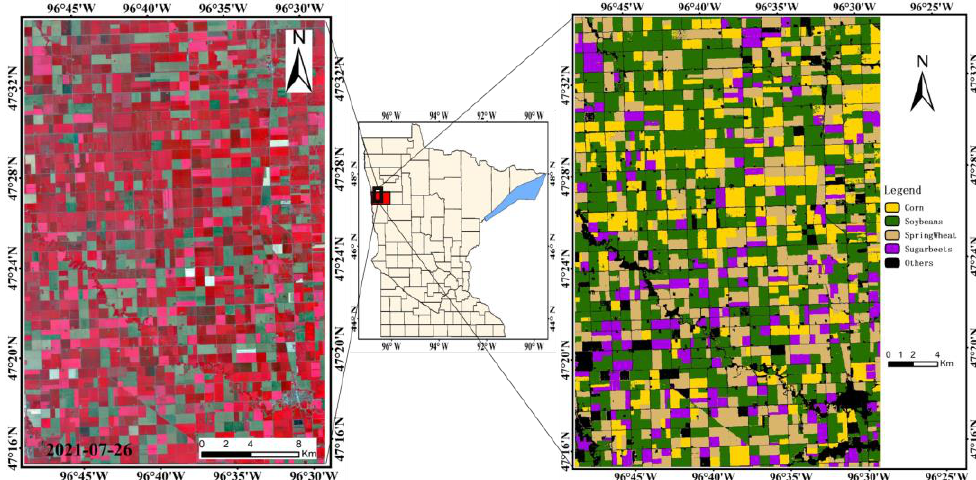
Figure 1. False color image and the Cropland Data Layer (CDL) of study